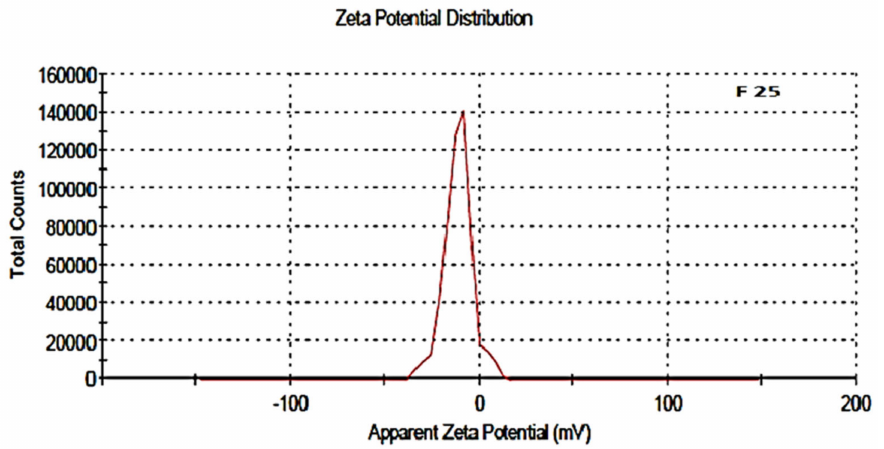
Figure 7. Zeta potential of drug-loaded polymeric NPs, F-25.